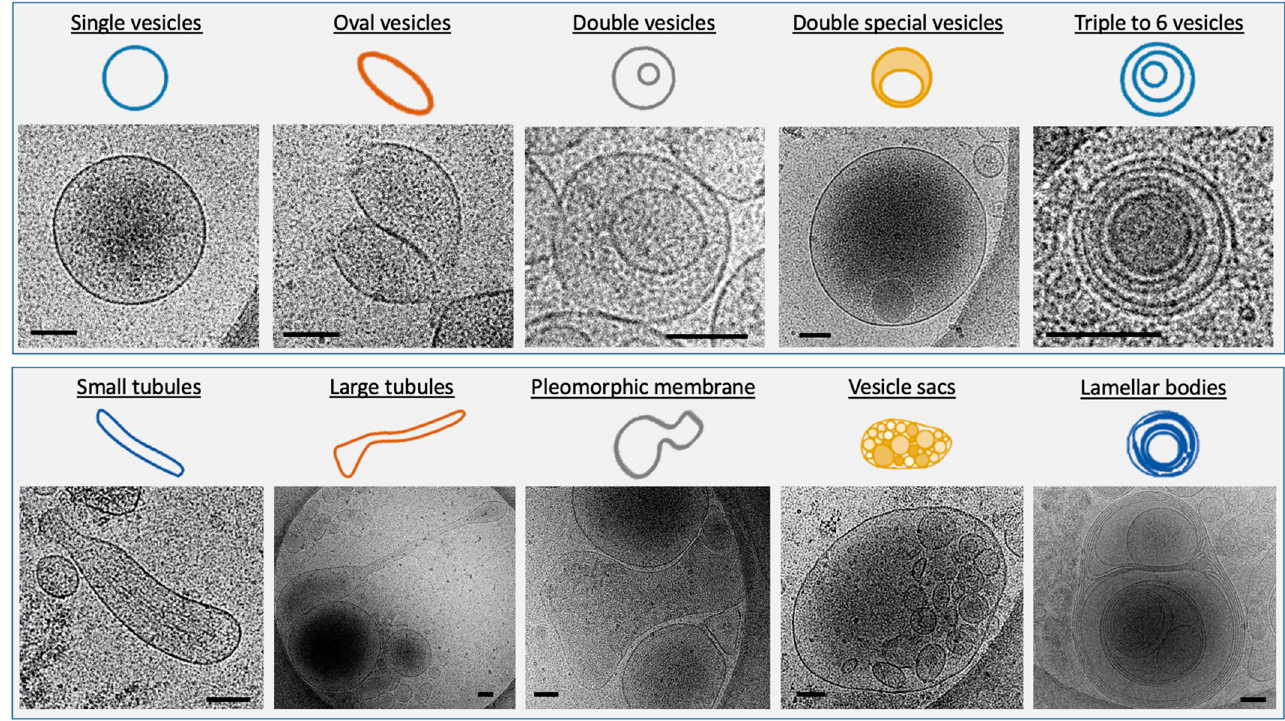
Figure 4. Cryo-TEM images of the 10 subcategories of EVs depending on their size and their morphology. Scale bar: 100 nm.